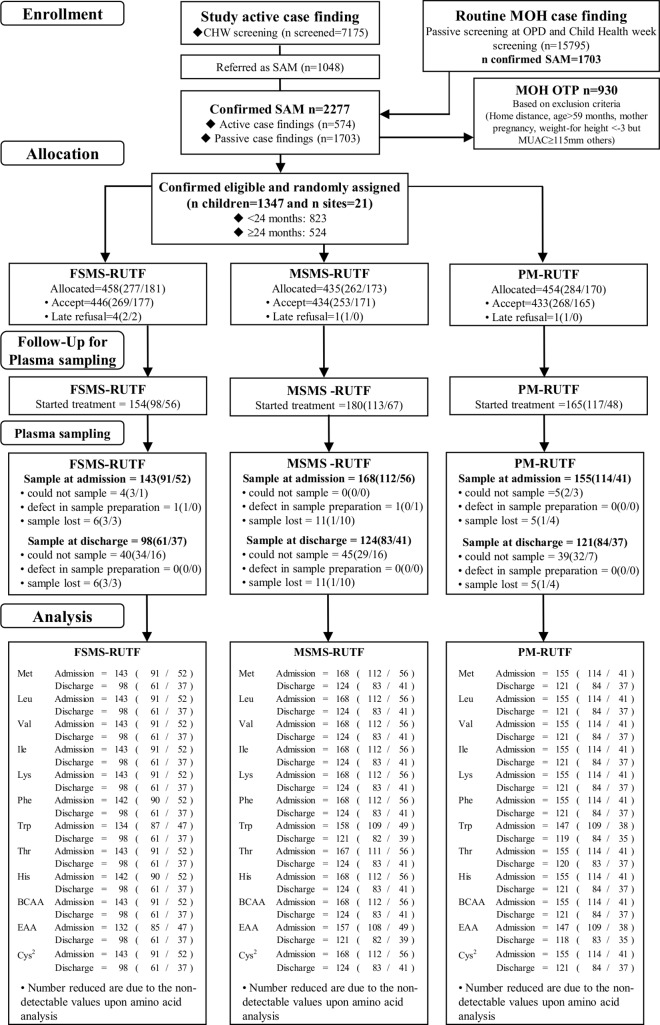
Study participant flow diagram.CHW, community health worker; MOH, Ministry of Health; OPD, outpatient department; OTP, outpatient program; SAM, severe acute malnutrition; MUAC, mid-upper arm circumference; FSMS, milk-free, soy, maize, and sorghum; RUTF, ready-to-use therapeutic food; MSMS, milk, soy, maize, and sorghum; PM, peanut and milk; Met, methionine; Leu, leucine; Val, valine; Ile, isoleucine; Lys, lysine; Phe, phenylalanine; Trp, tryptophan; Thr, threonine; His, histidine; BCAAs, branched-chain amino acids; EAAs, essential amino acids; Cys2, cystine.